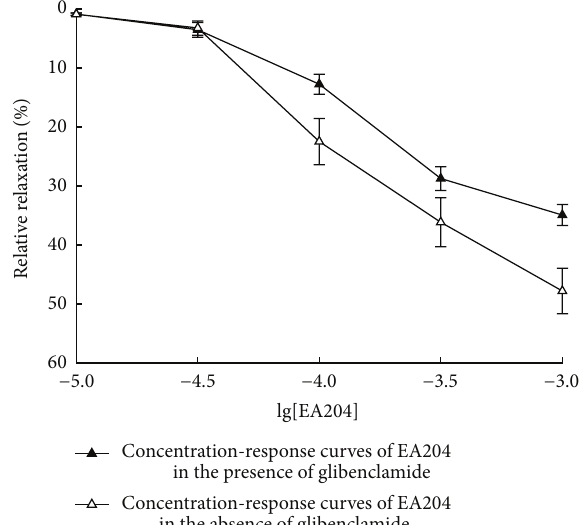
Figure 6: Cumulative concentration-response curves of EA204 in theabsenceorpresenceofglibenclamide(10 −5 M)ondenudedaortic rings of rabbits precontracted with KCl (60mM). Endothelium was removed mechanically by rubbing with a steel wire. Responses are expressed as a percentage of the maximum possible relaxation, that is, relaxation back to the baseline tension. Values indicated the means ± SEM ( 𝑛 = 8 ).